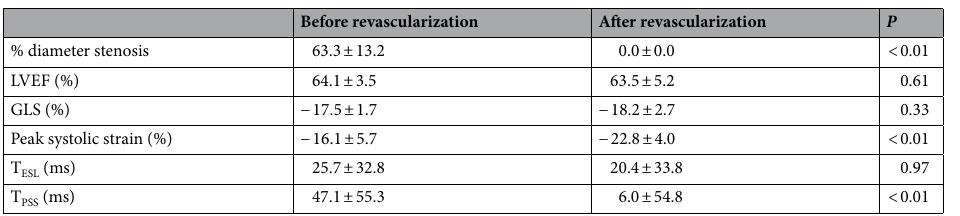
Table 3. Echocardiographic parameters before and after revascularization (16 patients). Data are presented as mean ± standard deviation. GLS, global longitudinal strain; LVEF, left ventricular ejection fraction.